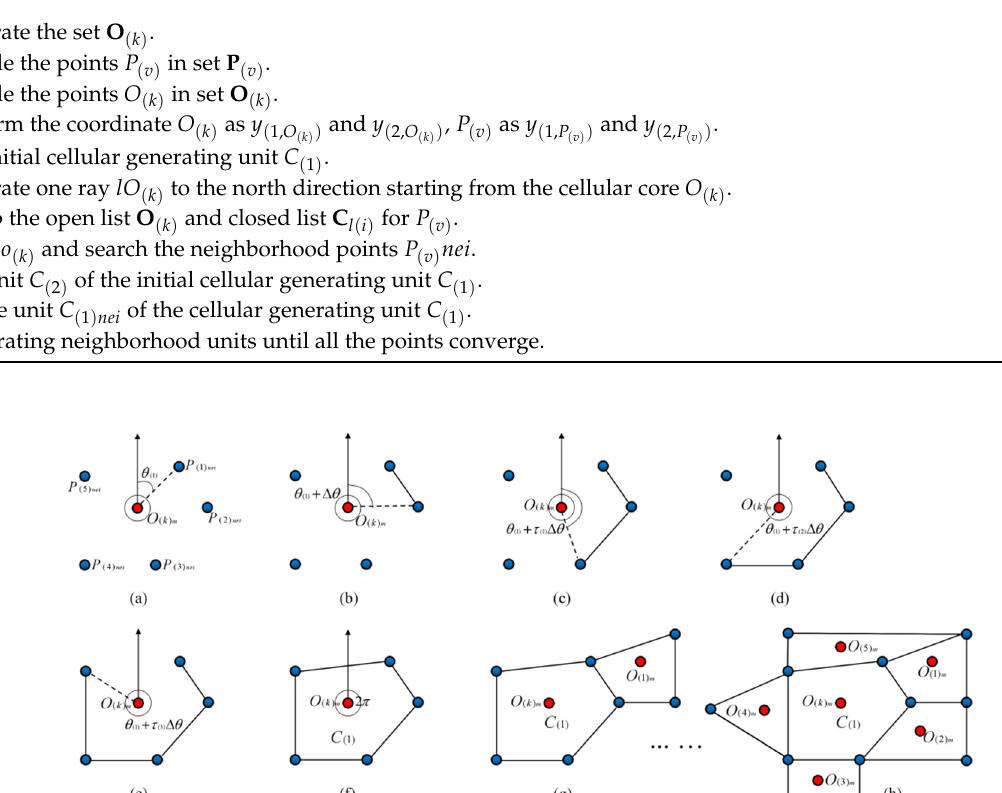
Algorithm 1 The cellular generating unit C ( k ) and cellular space C generating algorithm